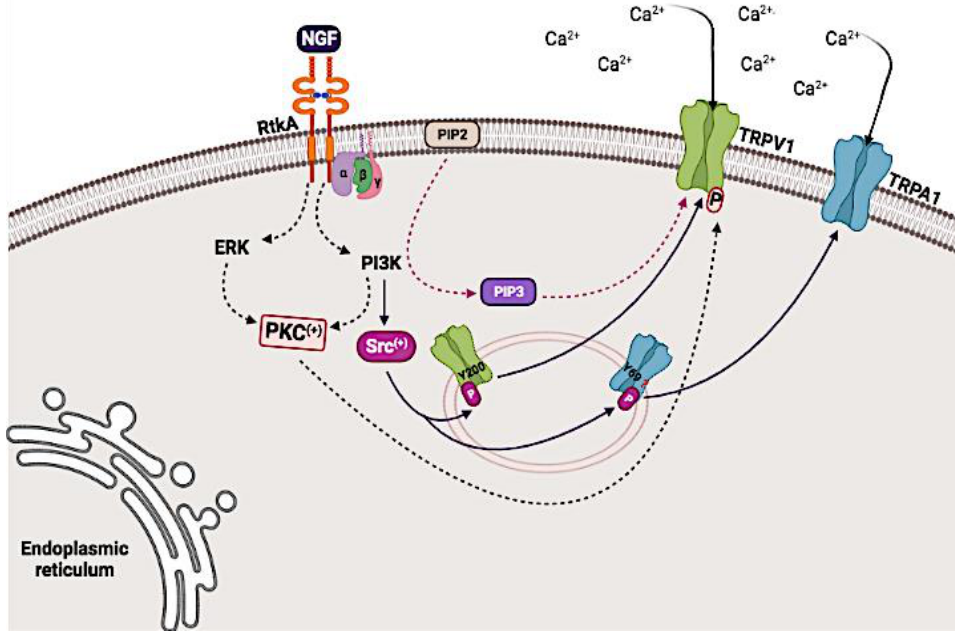
Figure 4. TRPV1 and TRPA1 channel sensitization mechanisms induced by nerve growth factor (NGF). NGF binds to its TrkA receptor to activate the MAPK-ERK and PI3K pathways, which activate protein kinase C (PKC) resulting in the phosphorylation and sensitization of the TRPV1 channel. Likewise, activation of PI3K mediates the enzymatic conversion of phosphatidylinositol bisphosphate (PIP2) to phosphatidylinositol triphosphate (PIP3), which promotes activation of TRPV1. Activation of PI3K leads to the activation of Src, which facilitates the trafficking of TRPA1 and TRPV1 towards the membrane. Created with BioRender.com, accessed on 28 June 2021.